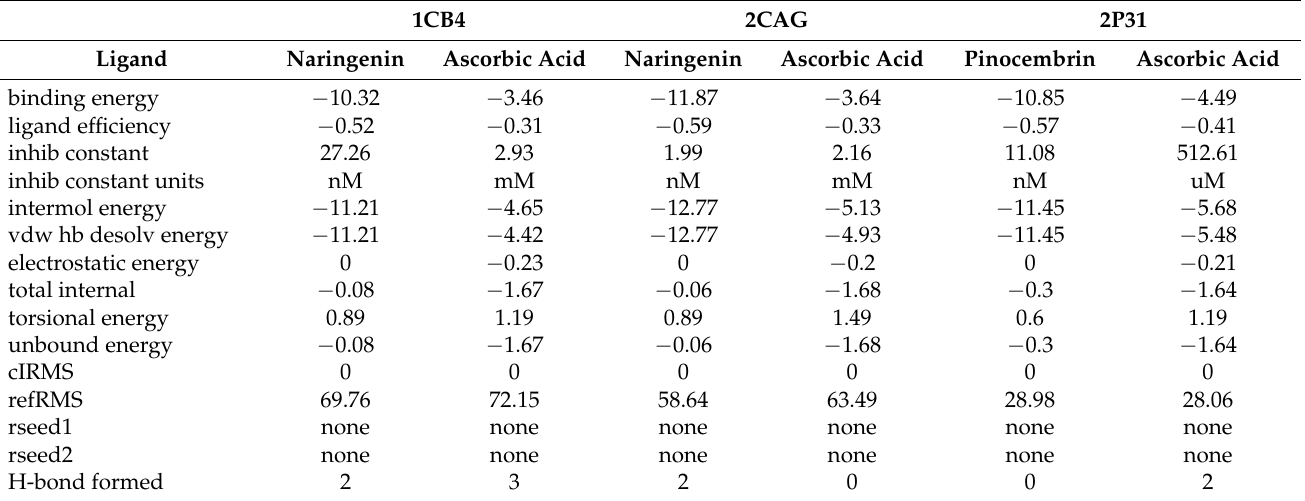
Table 1. Molecular Docking Top scored ligand-protein complex data for receptors 1CB4, 2CAG and 2P31. 1CB4 2CAG 2P31